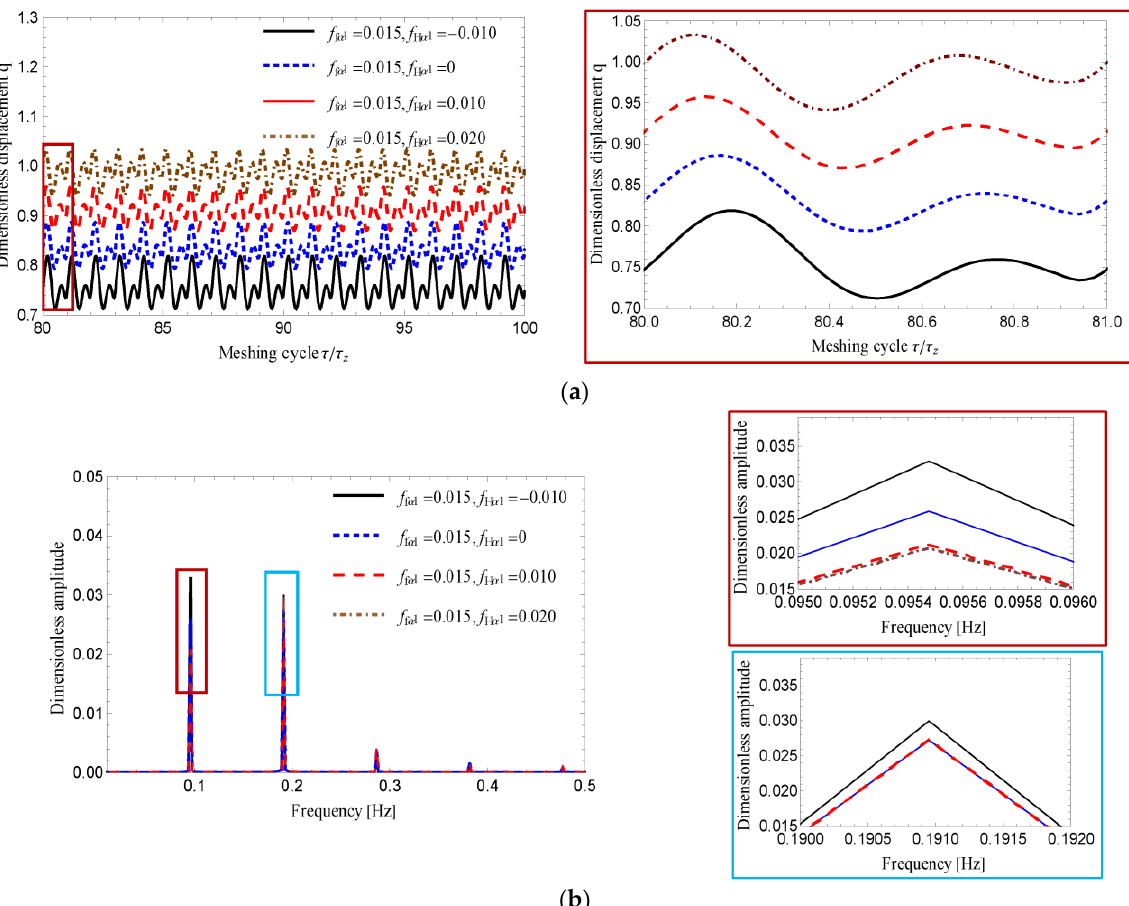
Figure 14. The dynamics characteristics with different 𝑓 𝐻𝛼1 : ( a ) time history diagram; ( b ) FFT The dynamics characteristics with different f H α 1 : ( a ) time history diagram; spectrogram. ( b ) FFT